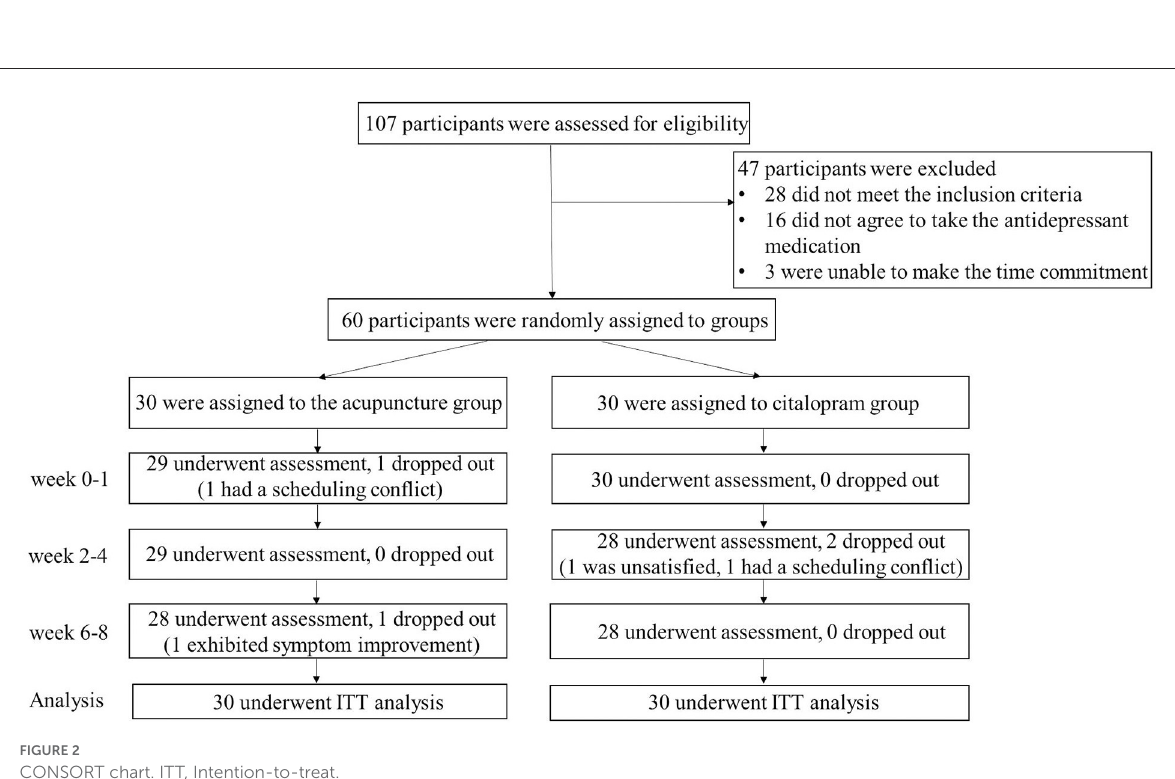
illustrated in Table 2. Between group differences in the effective rate were − 4.06% (95%CI: − 17.75%, 25.86%) and 7.14% (95%CI: − 17.15%, 30.30%, each P > 0.05) at weeks 4 and 8. Both the taVNS combined with electroacupuncture and citalopram groups showed reductions in depressive and pain